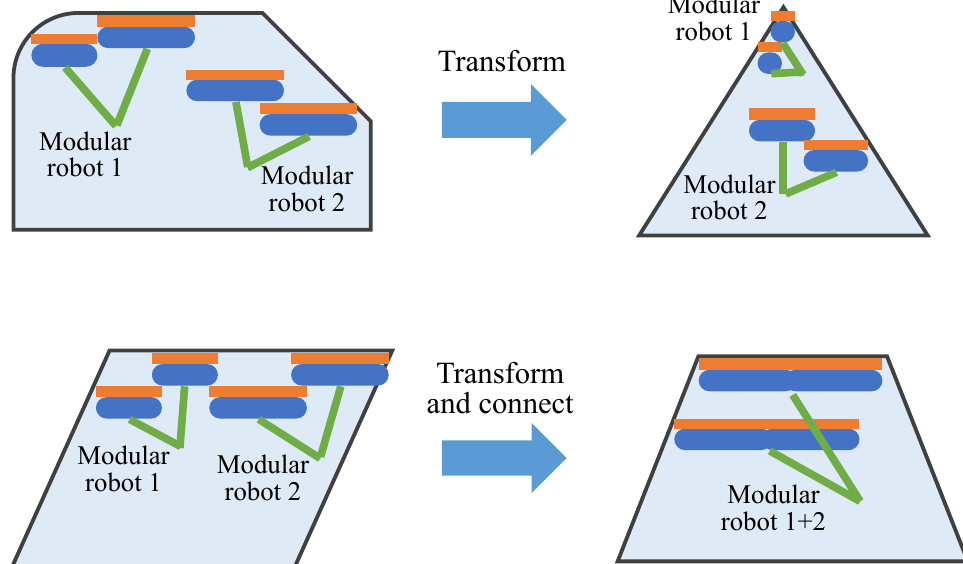
Figure 1. Concept of nested reconfigurable robots for façade cleaning. The concept employs multiple modular multilegged robots capable of reconfiguring their morphology based on window shapes. The modular multilegged reconfigurable robots can transform their own modules and connect with each